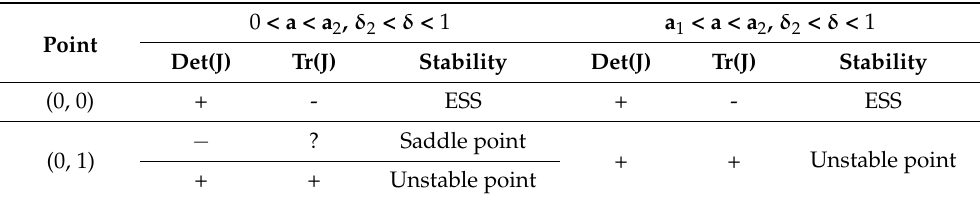
Table 7. Stability analysis of the points in case